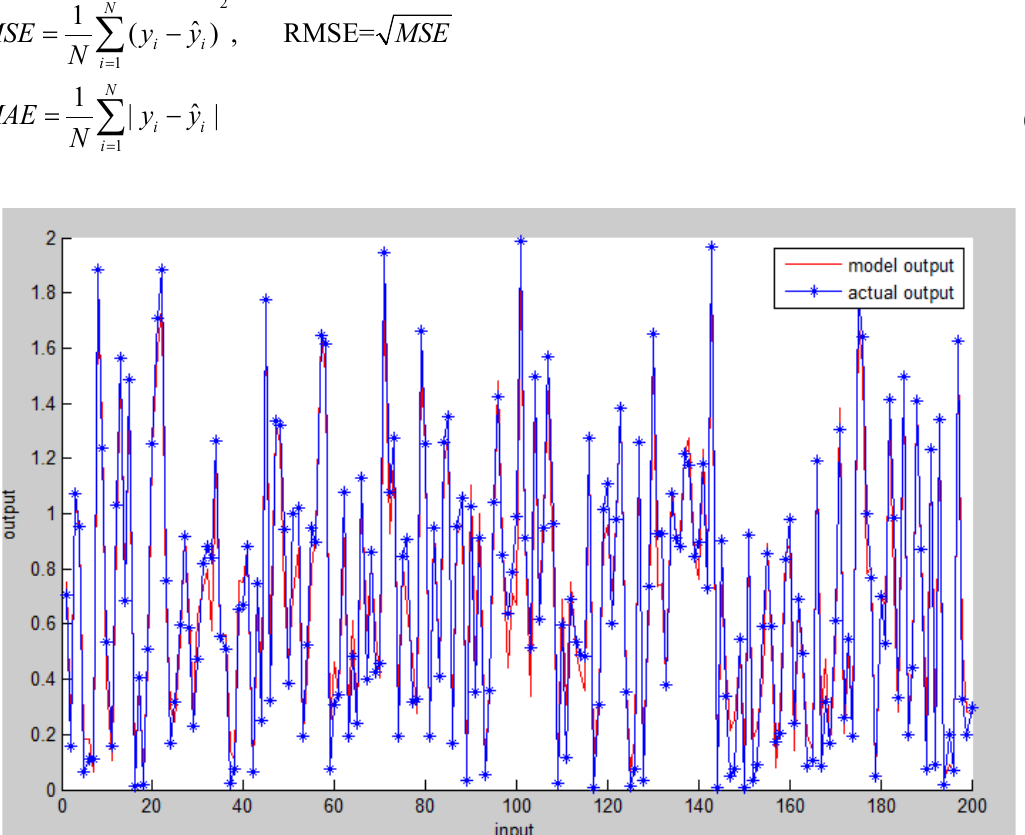
Figure 4. The comparison of model output and actual